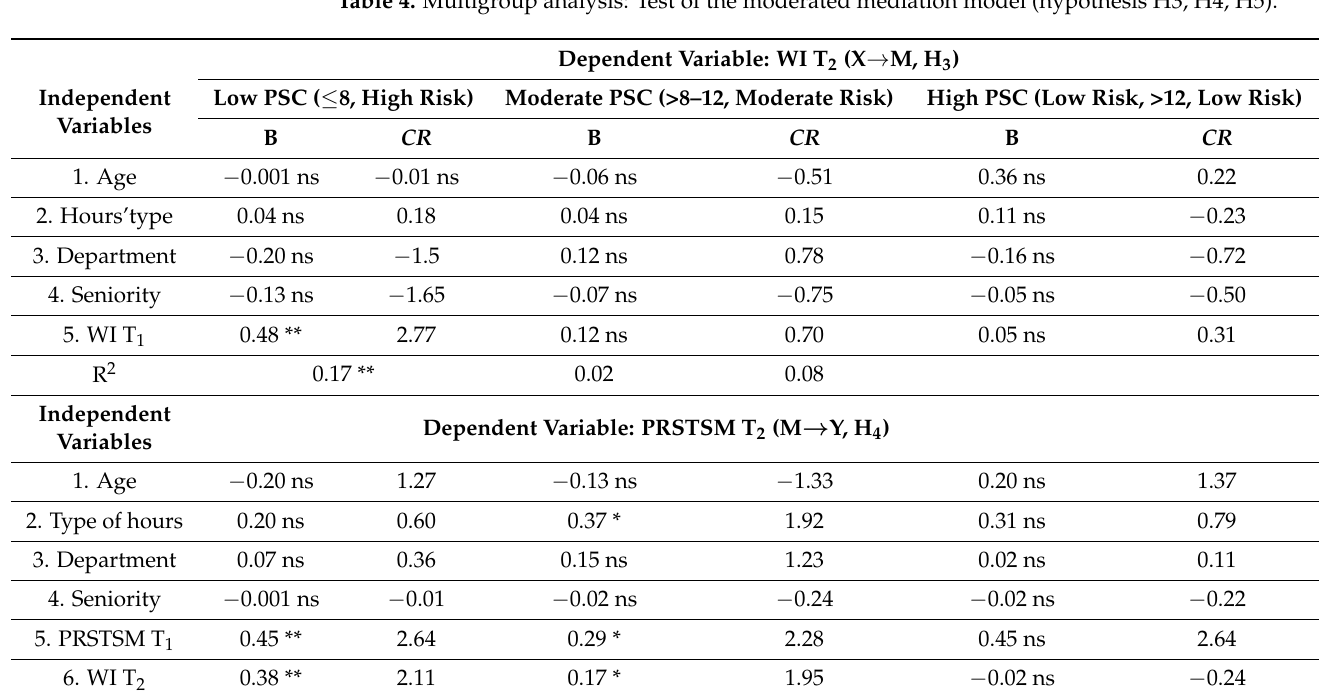
Table 4. Multigroup analysis: Test of the moderated mediation model (hypothesis H3, H4,